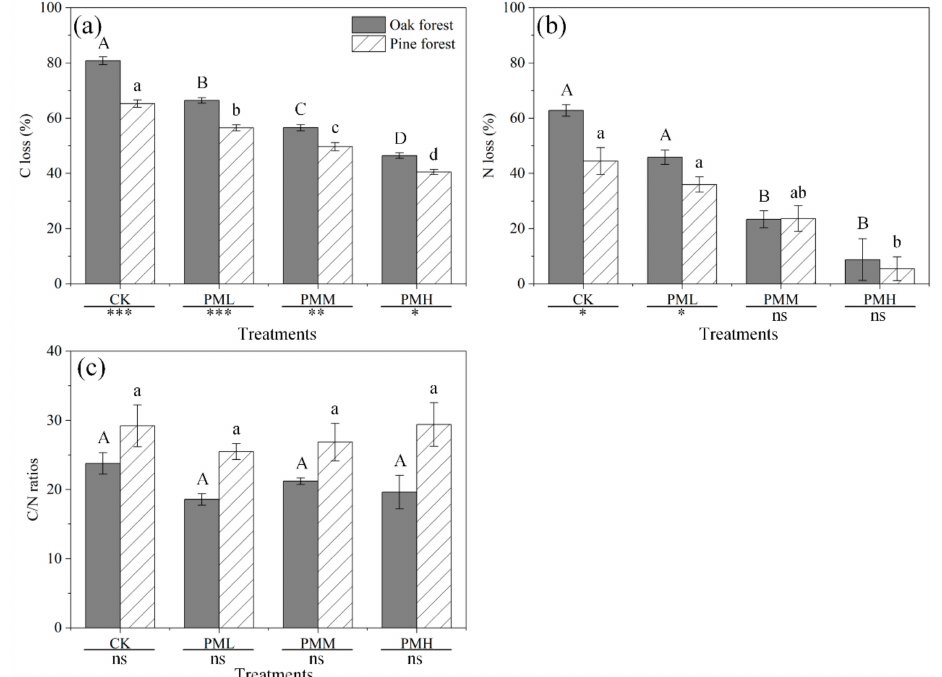
Figure 3. Leaf litter (a) C loss, (b) N loss, and (c) changes in the C / N ratios (T0–T6) after six-month decomposition (mean ± SD, n = 4). Abbreviations: CK—control; PML—low concentration WSII–PM 2.5 ; PMM—medium concentration WSII–PM 2.5 ; PMH—high concentration WSII–PM 2.5 . Different uppercase and lowercase letters indicate significant differences ( p < 0.05) in oak and pine forests, respectively. Asterisks indicate statistical significance: * p < 0.05; ** p < 0.01; *** p < 0.001; ns, not